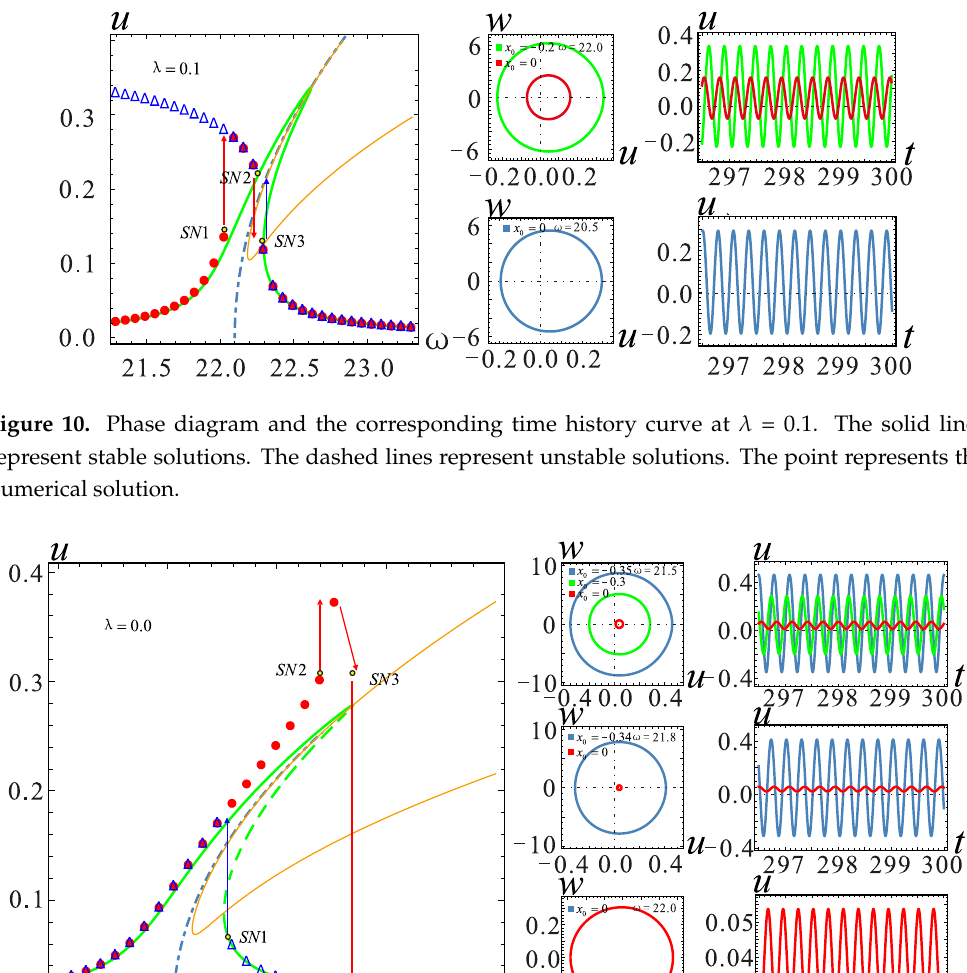
Figure 9. Phase diagram and the corresponding time history curve at λ = –0.1. The solid lines represent stable solutions. The dashed lines represent unstable solutions. The point represents the numerical solution.